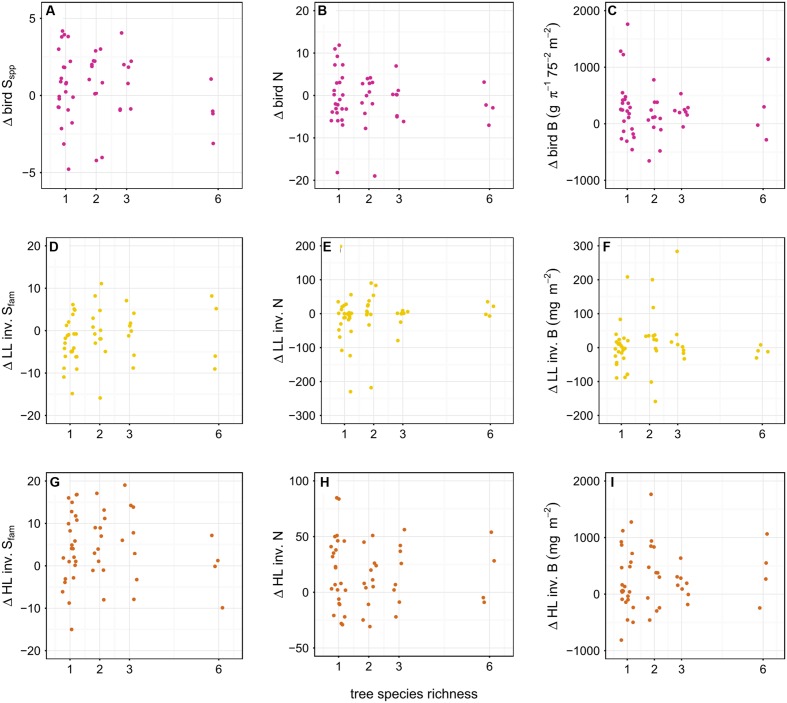
Effect of tree diversity on the difference in richness (Sspp = species level, Sfam = family level), abundance (N) and biomass B of birds (A–C), leaf-litter (LL) (D–F) and herb-layer (HL) (G–I) invertebrates (inv.) between year one and the baseline. Birds were considered on species level, invertebrates on family level. There was no effect of tree diversity on any of the responses. To avoid overplotting of data points, we used the ‘jitter’ function in R (R Core Team, 2015).